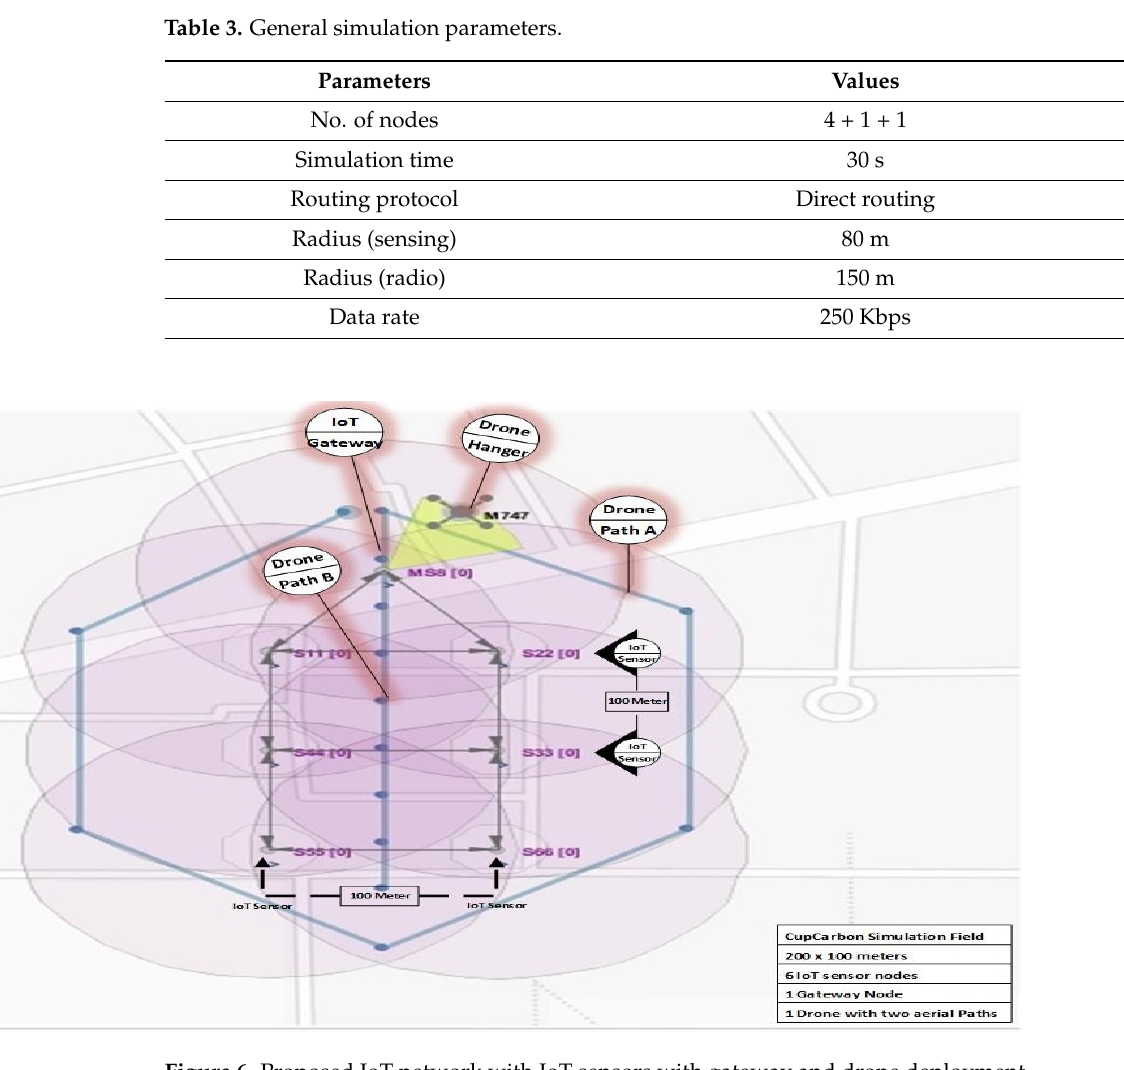
Table 3. General simulation parameters.